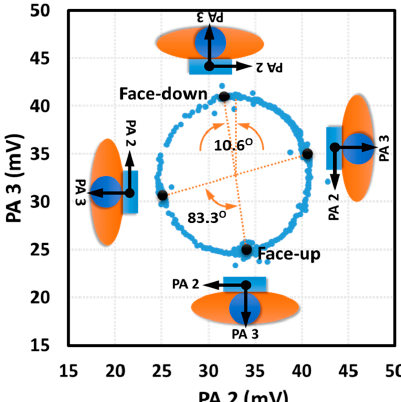
Figure 6. A simulation of elderly and infant turning-over monitoring. By simultaneously combining the features extracted from the Lying-to-TL and -TR cases, the states of face-up and face-down can clearly recognized using the proposed DDFM algorithm. The inclination might be caused by the unbalanced natural motional strength of the